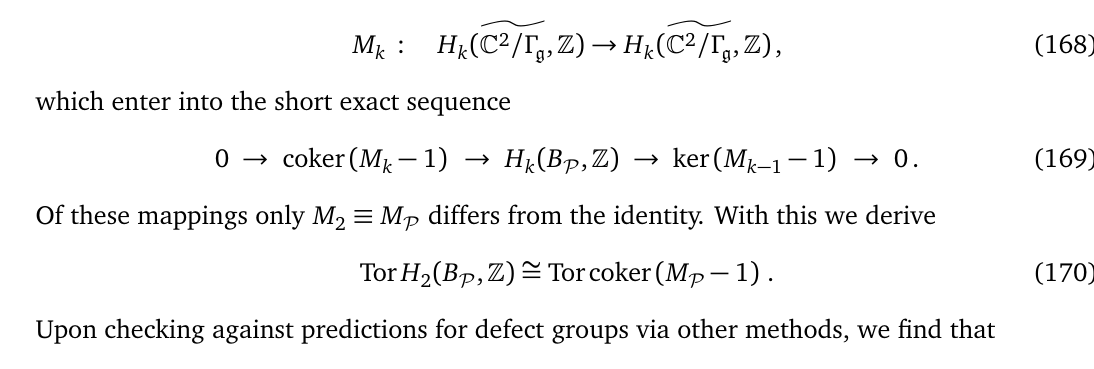
Figure 25: We depict the IIB geometry X puncture P . The boundary of the ALE fibration X Here, the superscript ab denotes the abelianization of the